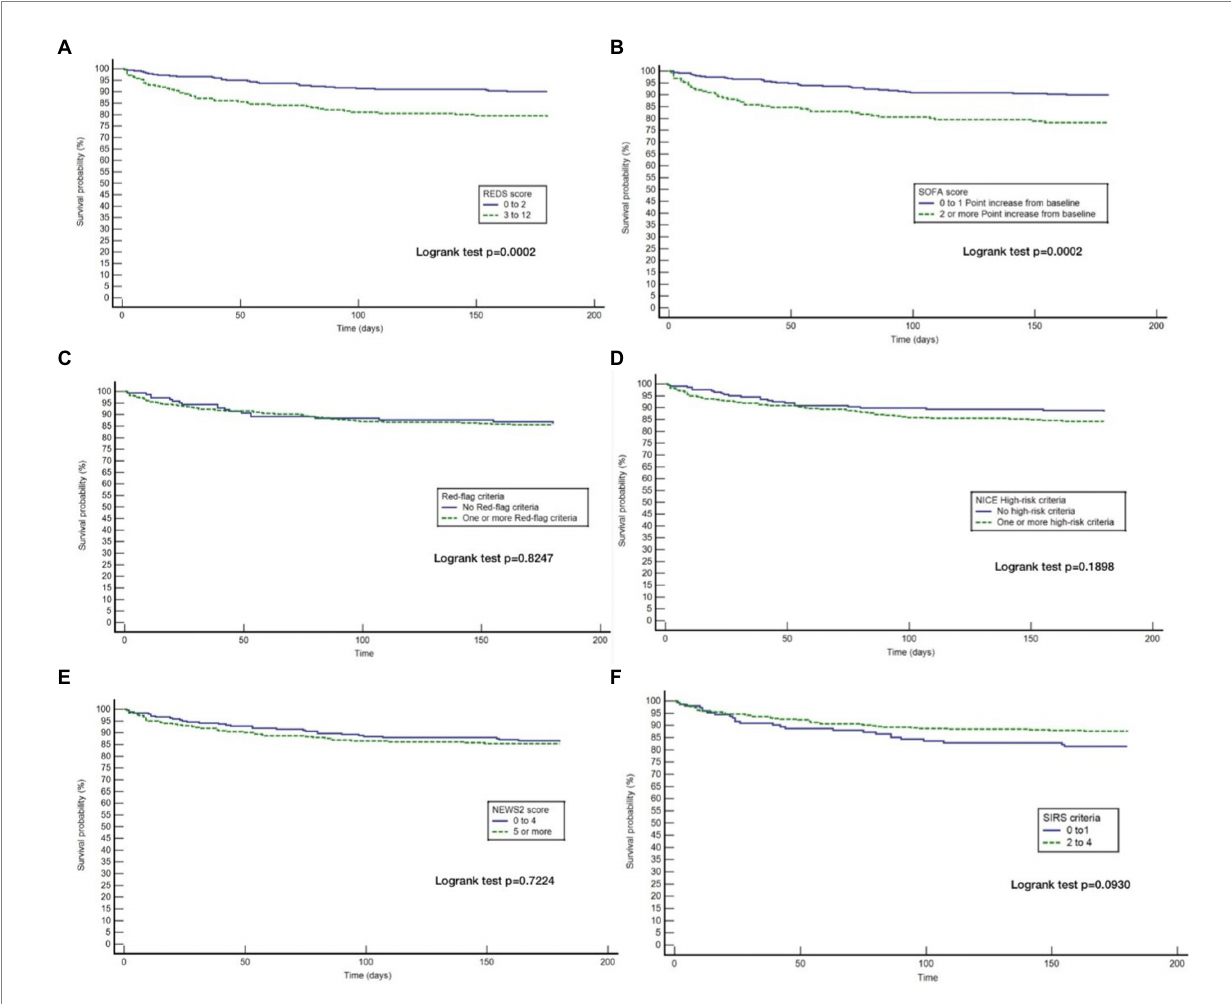
FIGURE 4 Kaplan Meier curves for 180 day survival for those without specified* co-morbidities stratified by the different tools. (A) Kaplan Meier curves for 180 day survival as stratified by the REDS score; (B) Kaplan Meier curves for 180 day survival as stratified by the SOFA score; (C) Kaplan Meier curves for 180 day survival as stratified by the Red = flag criteria; (D) Kaplan Meier curves for 180 day survival as stratified by the NICE criteria; (E) Kaplan Meier curves for 180 day survival as stratified by the NEWS2 score; (F) Kaplan Meier curves for 180 day survival as stratified by the SIRS criteria. *Specified comorbidities, presence of any one of the following: dementia, malignancy, care home residency or a minimum three times a day care package, on long-term oxygen therapy (LTOT) or a previous do-not-resuscitate